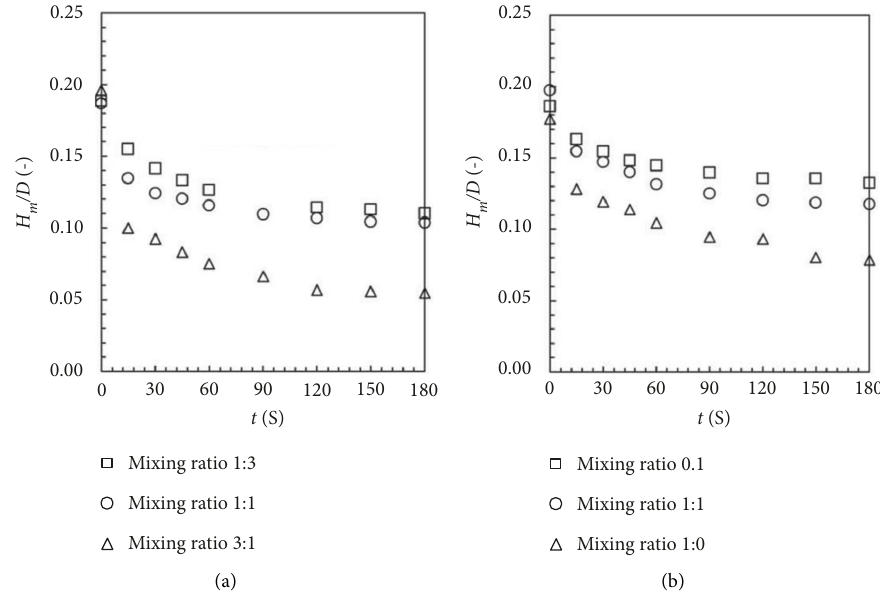
Figure 13: Self-leveling behavior for mixed particles with different volumetric mixing ratios [42, 43]. (a) Mixed density (Spherical Al2O3 and SS particles, dp =2mm, Qg=200L/min) (b) Mixed size (Spherical SS particles, dp =2 and 4mm, Qg=200L/min)